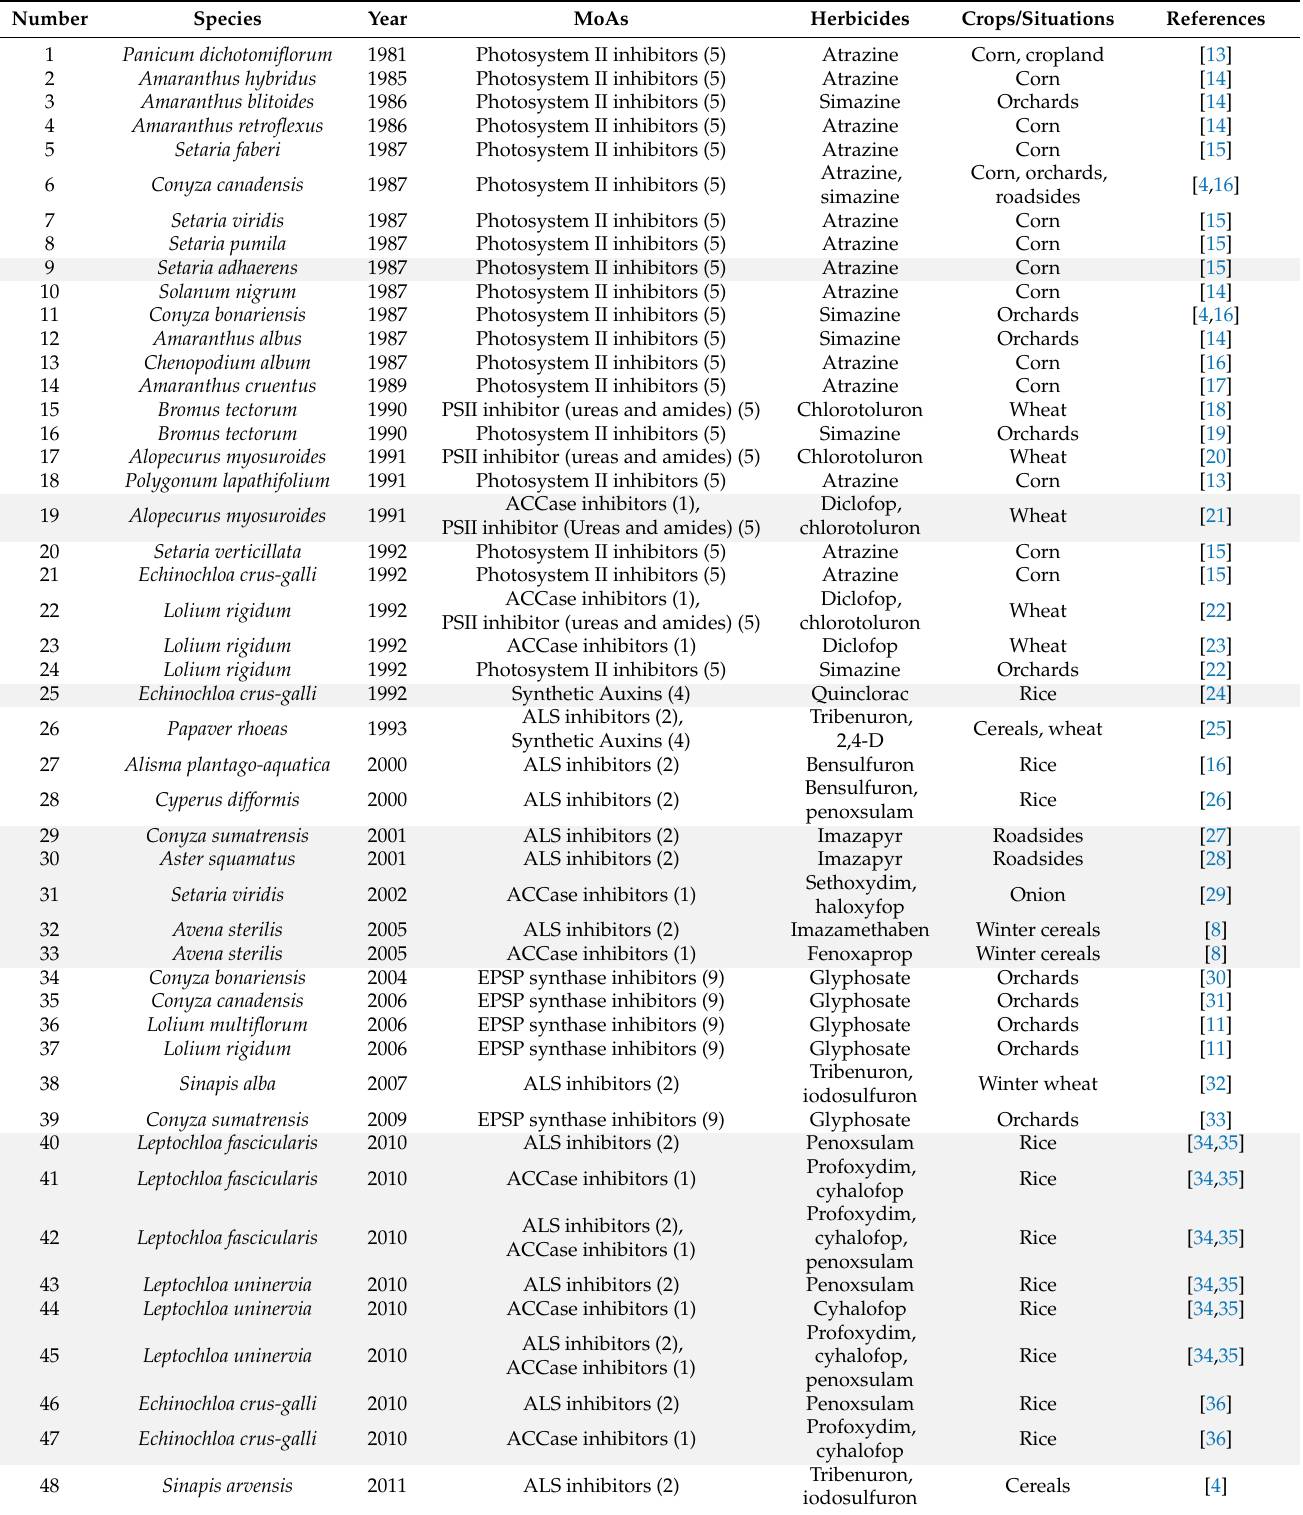
Table 2. Herbicide-resistant weeds of Spain. Last column details the reference acknowledging the resistant case. Resistance cases under grey background (25 in total) are those not included in Heap database